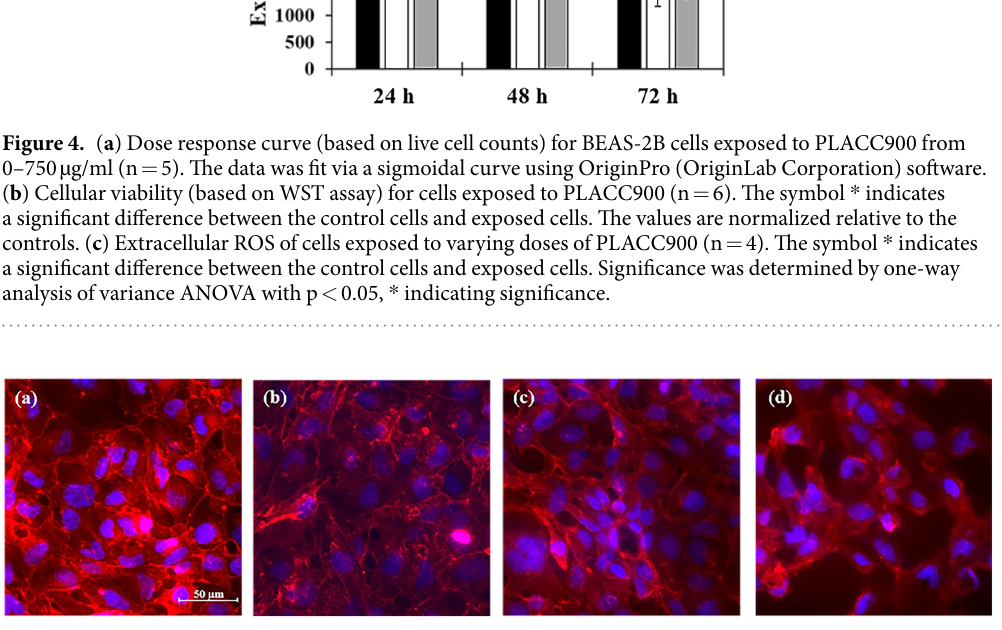
Figure 5. Fluorescent images of the cell membrane (red) and nucleus (blue) for ( a ) control cells and cells exposed to PLACC900 at ( b ) 100 µ g/ml, ( c ) 300 µ g/ml, and ( d ) 500 µ g/ml after 24